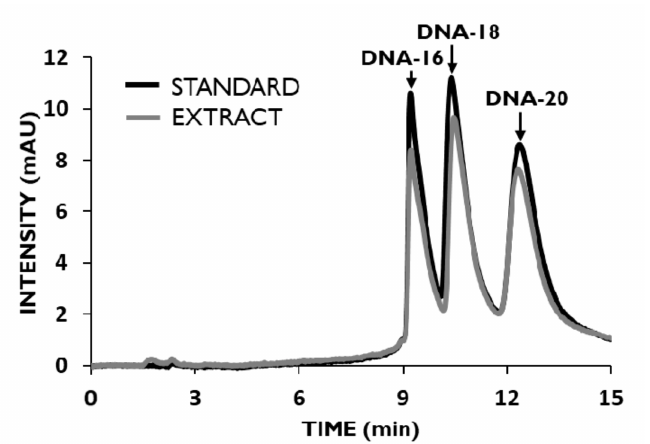
Figure 7. Chromatograms for the separation of DNA-20 and its synthetic metabolites DNA-18 and DNA-16 from standard solution (black line) and extract, obtained with developed MDSPE (gray line). Experimental conditions: mobile phase, 10 mM NH 4 OAc and MeOH; gradient elution, 5–20% of MeOH in 5 min and next 20–25% of MeOH in 10 min; chromatographic column ACE Excel C18, 1.7 µ m; UV detection at λ = 260 nm; column and autosampler temperature, 30 ◦ C; flow rate, 0.15 mL min − 1 ; injection volume, 2 µ